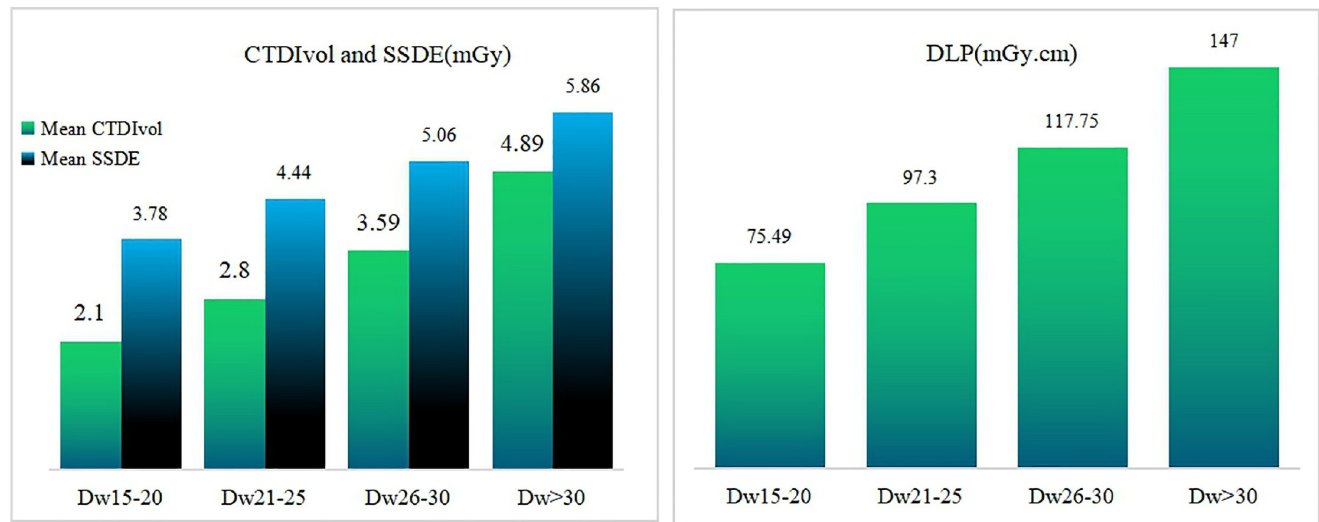
Fig 3. Comparison of CTDIvol, DLP, and SSDE among different size groups. The CTDIvol was smaller than SSDE in each subgroups.